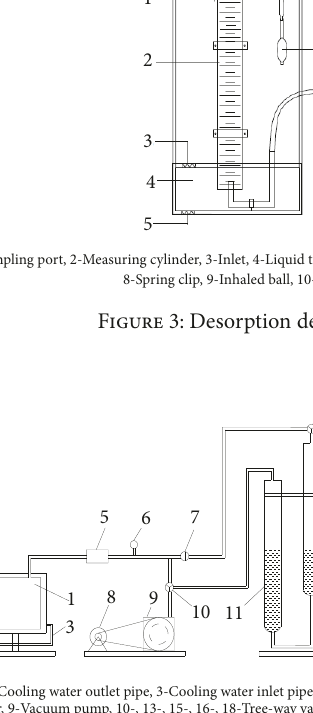
Figure 4: Hydrogen sulfide content measuring device of coal